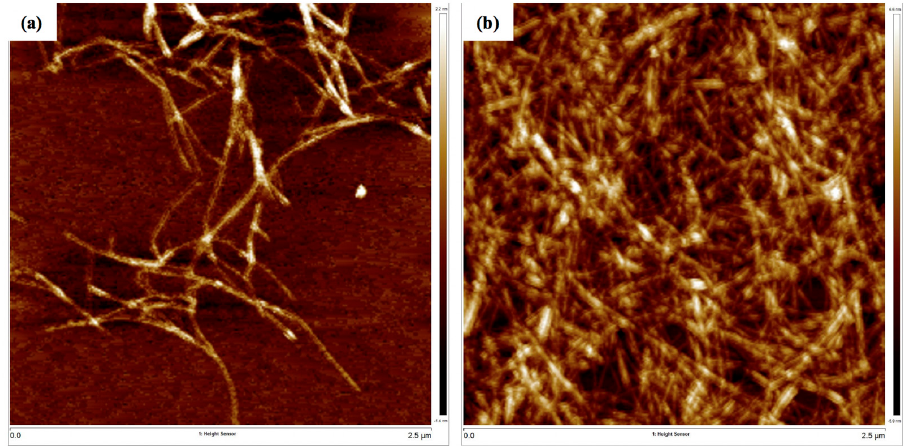
Figure 7. AFM images of ( a ) NOCNF (0.32 wt%) and ( b ) NOCNF-Tl floc (0.32 wt% NOCNF with 300 ppm Tl(I)).